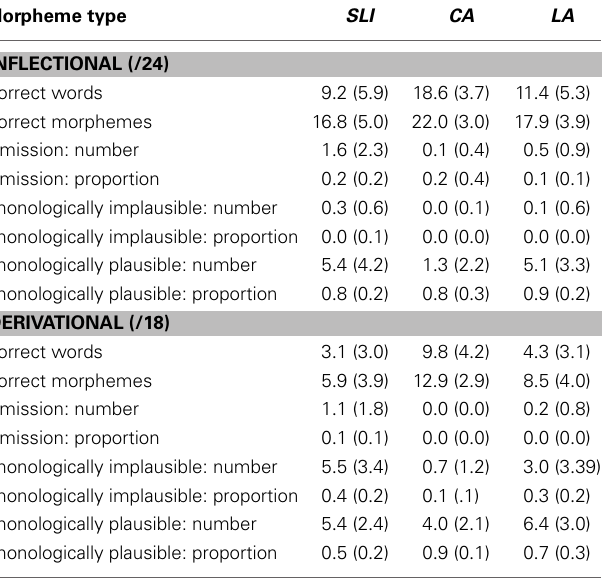
Table 3 | Means and standard deviations for the number of words and morphemes spelled correctly and number and proportions of error types (omission, phonologically implausible, non-phonologically plausible) according to Group (SLI, CA, LA) and morpheme type (Inflectional,